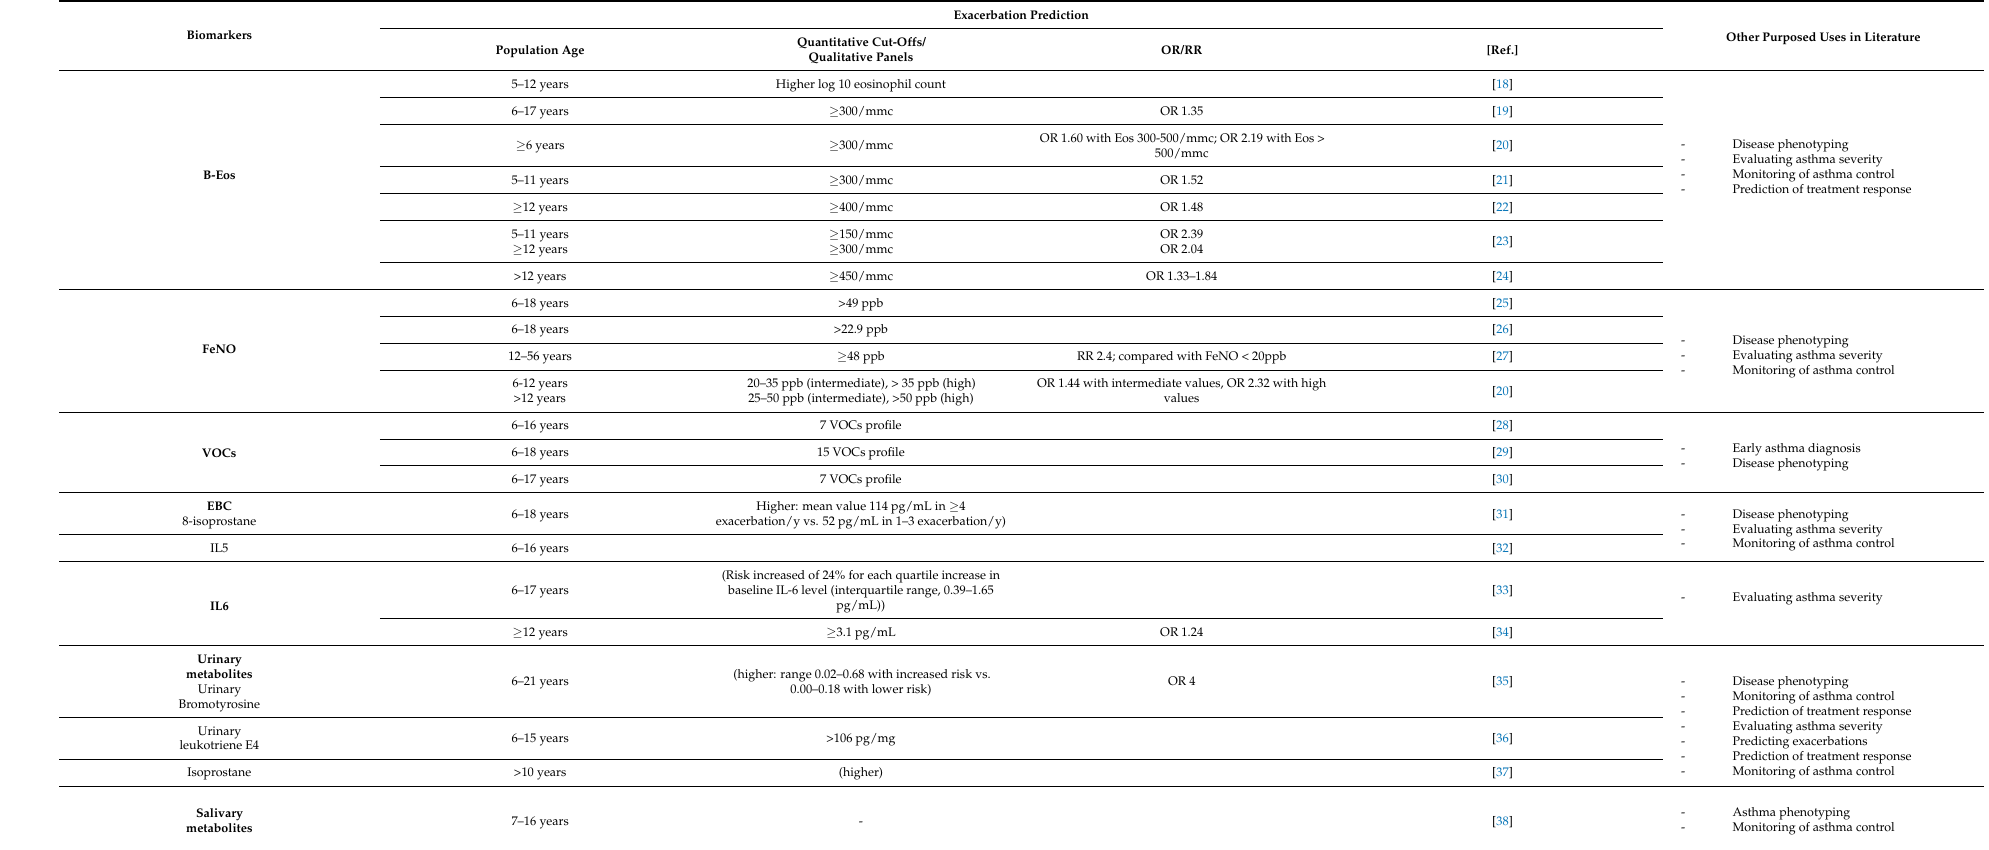
Table 1. Summary of studies investigating the role of biomarkers in asthma